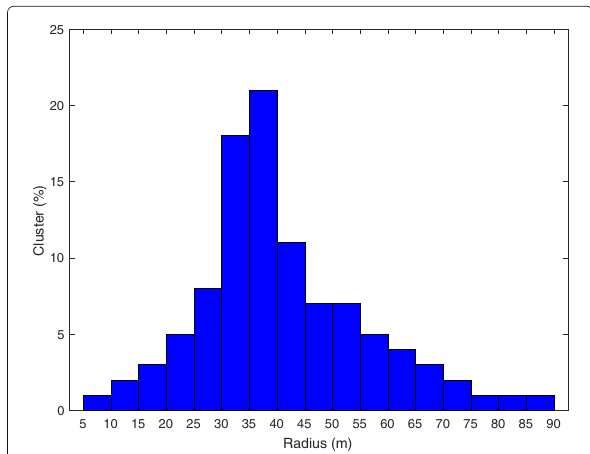
Fig. 8 Clusters radius distribution. This histogram represents the results on an analysis on a hundred of iterations that have been performed and half of the radius measured are between 30 and 45 m